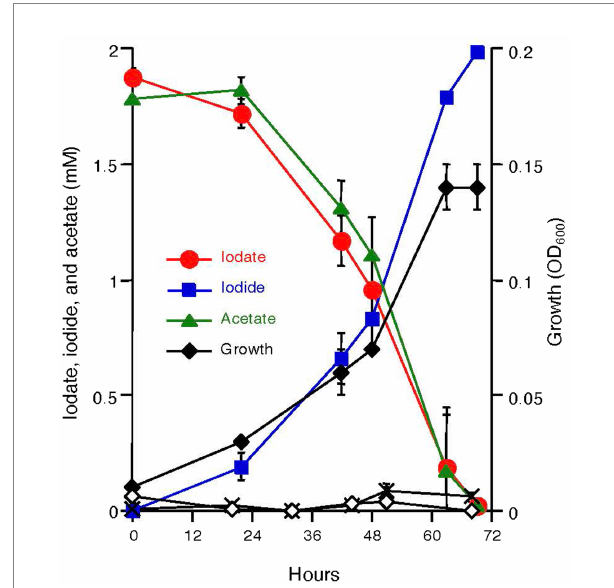
FIGURE 1 Growth of strain DN11 with 2 mM acetate as the electron donor and 2 mM iodate as the electron acceptor. Growth in the absence of acetate (white diamonds) and in the absence of iodate (crosses) is also shown. All experiments were performed in triplicate, and error bars represent standard deviations. The absence of bars indicates that the error is smaller than the